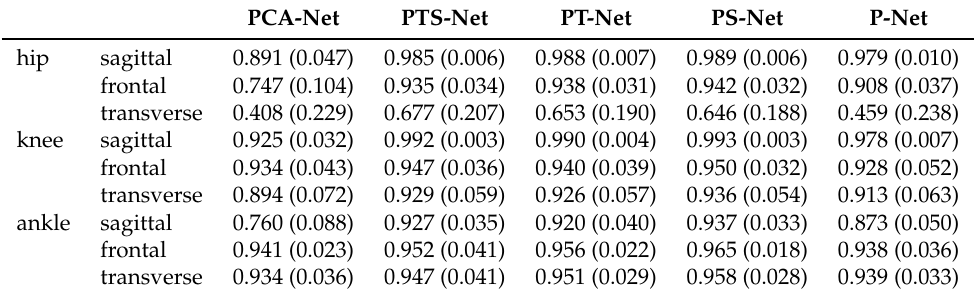
Table 2. Mean (standard deviation) of the correlation coefficient for the five-fold cross-validation using the different input parameters. The joint angles predicted for the left and right have been summarised.